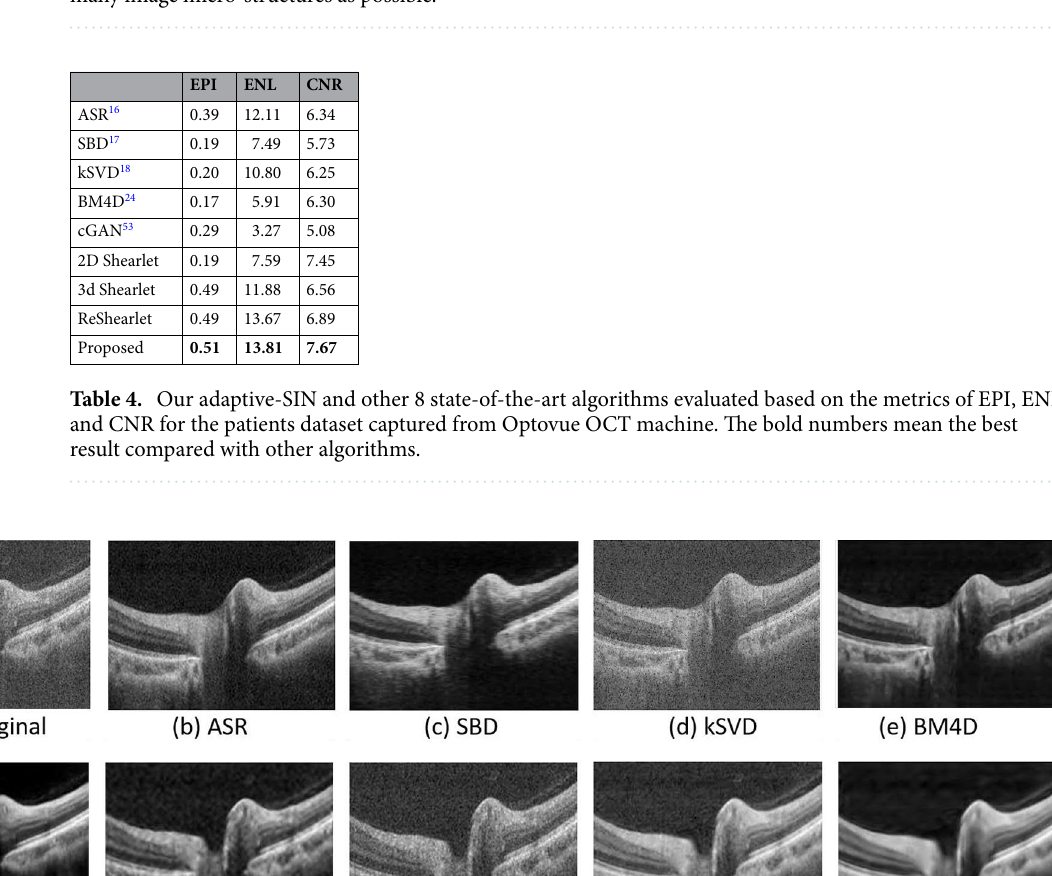
Figure 8. Sample OCT images of diseased eyes from Topcon OCT machine by our adaptive-SIN and other 8 algorithms for the performance evaluation. The proposed approach better removes the noise and preserves as many image micro-structures as possible.